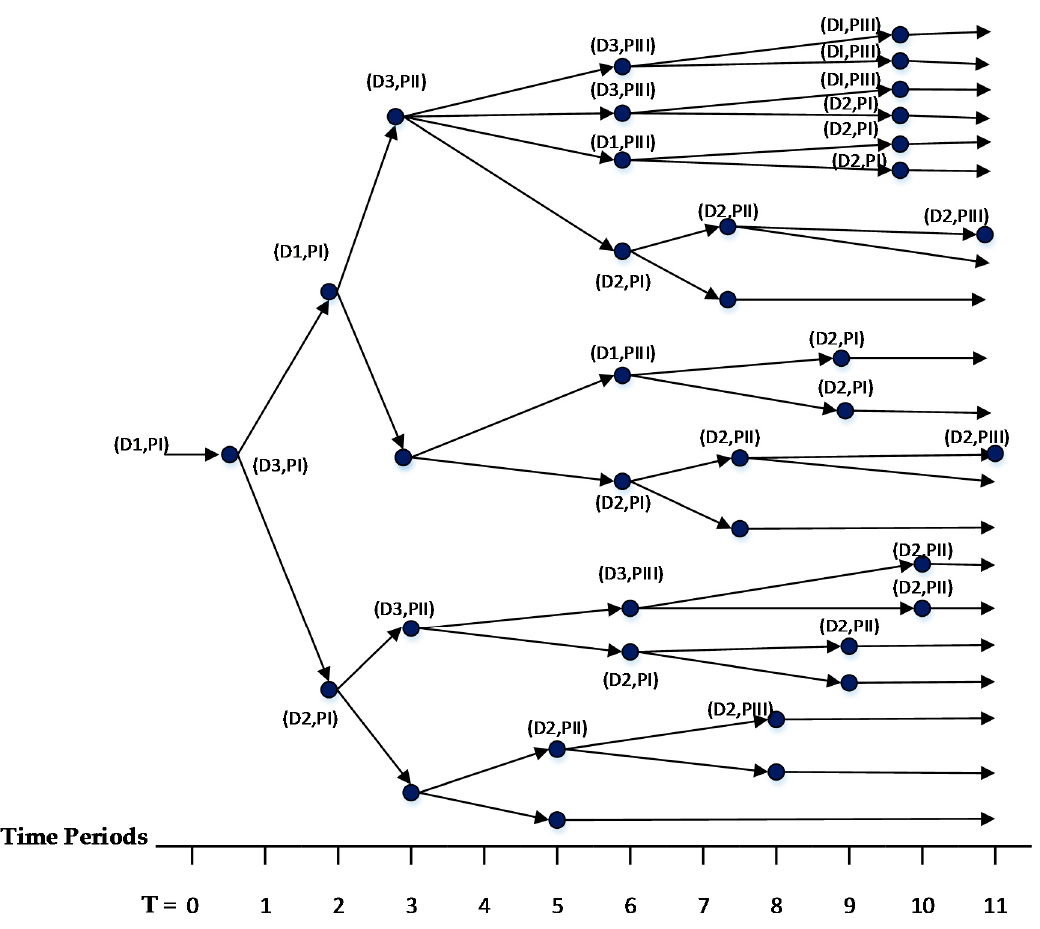
Figure 3. Multi-stage decisions in the optimal solution.